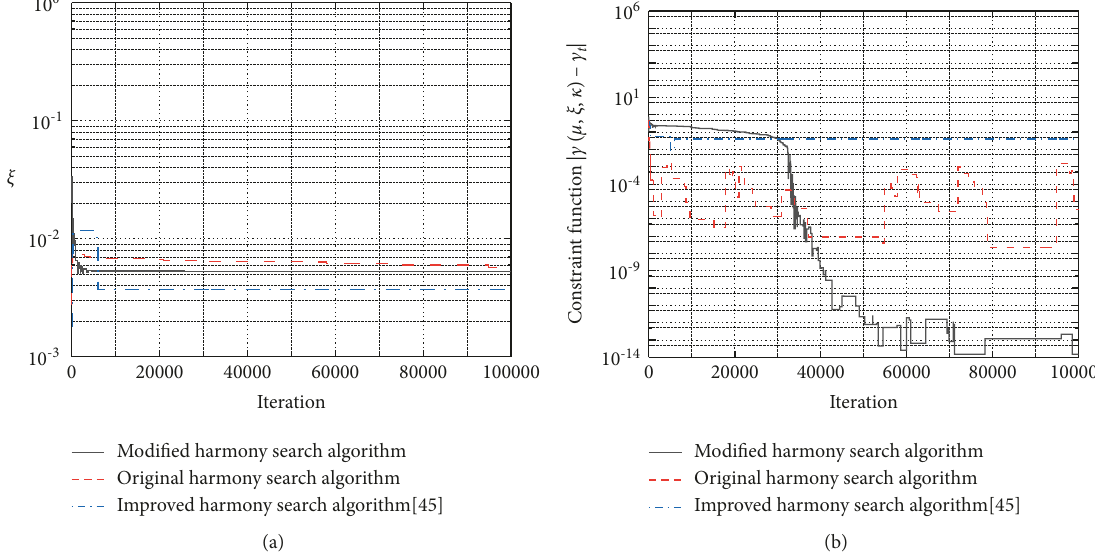
Figure 9: The variation trends of key indices during the optimization process for case 5. (a) The nominal damping ratio ξ . (b) The constraint function | c ( μ , ξ , κ ) − c t | .